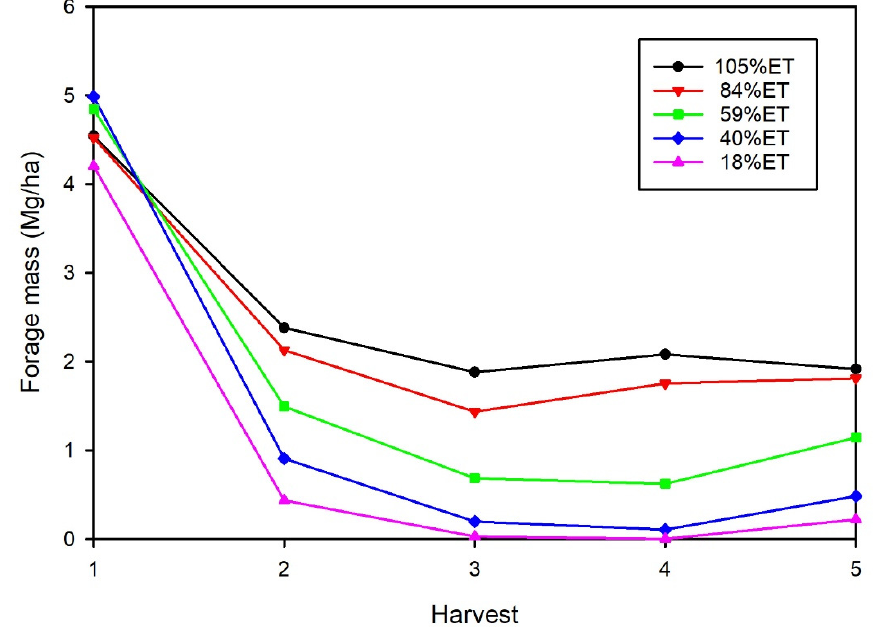
Figure 2. The effect of harvest on seasonal total forage mass for 28 tall fescue half-sib families evaluated for forage mass in a line-source irrigation experiment with 5 water levels (percentage of evapotranspiration replacement, %ET) from 2001 to 2003 near Logan, UT, USA.